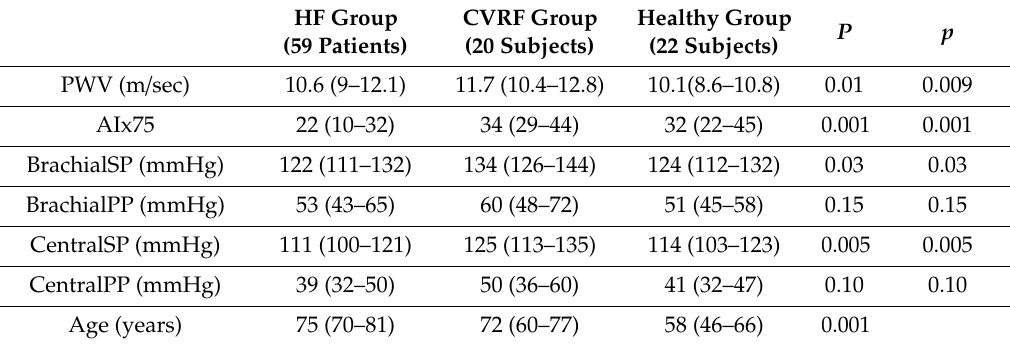
Table 2. The results of arterial sti ff ness determination and age in the heart failure (HF) group and in the two control